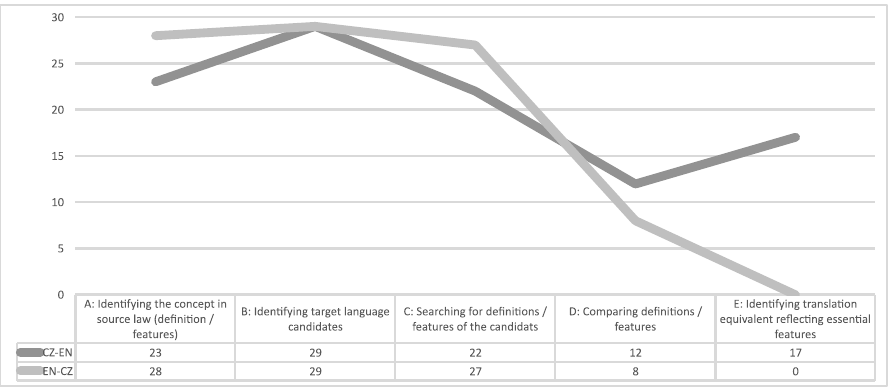
Figure 3. Total number of subjects completing individual CCA